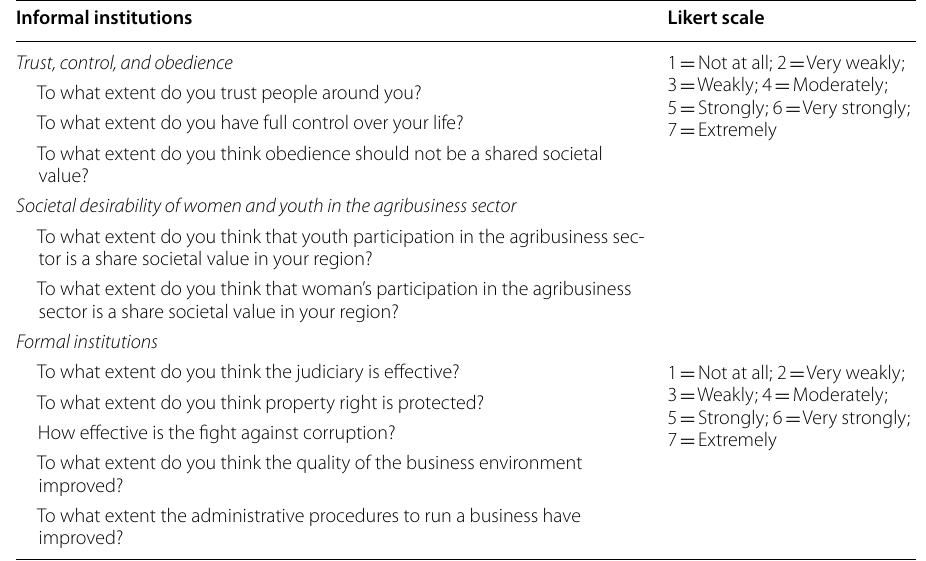
Table 11 Sample questions on informal and formal institutions related to participation in the agribusiness sector. Source : Authors,